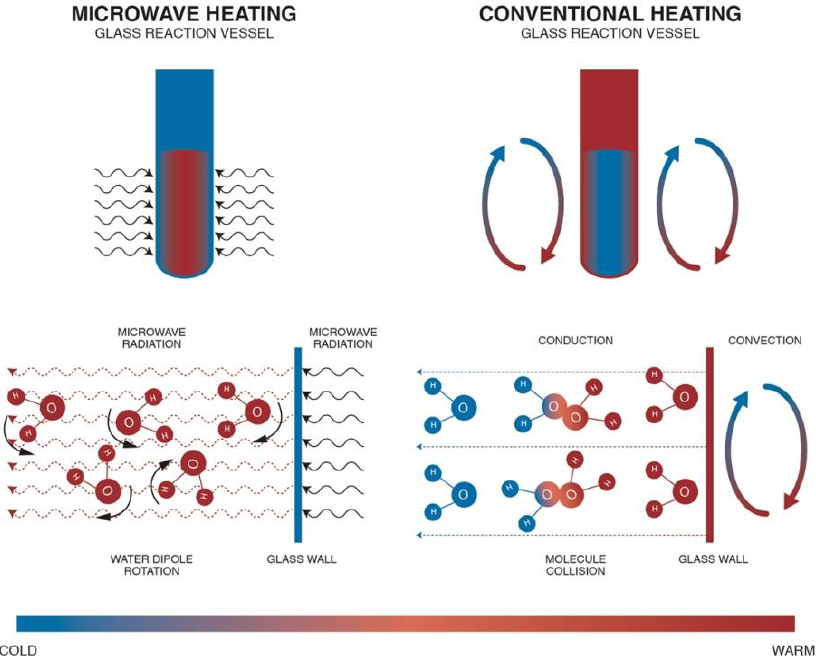
Figure 11. Comparison of conventional heating with microwave heating on the example of heating a water sample. Reprinted with permission from [460], Copyright © 2018 Sweygers et al., Article licensed under a CC BY 4.0, https: // creativecommons.org / licenses / by / 4.0 /